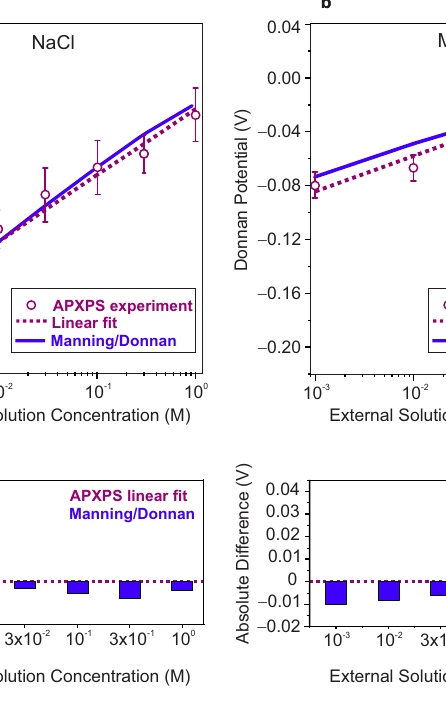
Fig. 3 | Comparison between the experiment and theory. Comparison of experimentally measured Donnan potential values obtained from binding energy shifts in membrane related core levels with the Manning/Donnan model predic- tionsasafunctionofexternal a NaCland b MgCl 2 solutionconcentration.Errorbars represent experimental uncertainty and are the standard deviation of repeated measurements of a minimum of four different locations in each case. Dashed lines are the linear fi ts of ambient pressure X-ray photoelectron spectroscopy (APXPS) experimental data for external NaCl and MgCl 2 solutions with slopes of